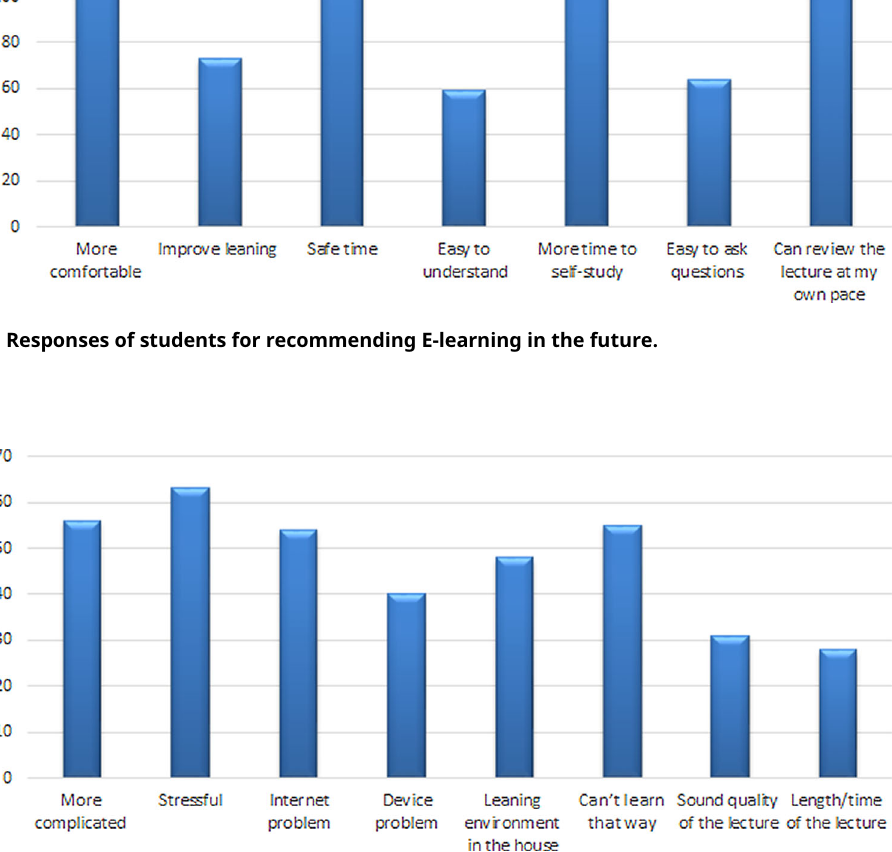
Figure 3. Response of students for not recommending E-learning in